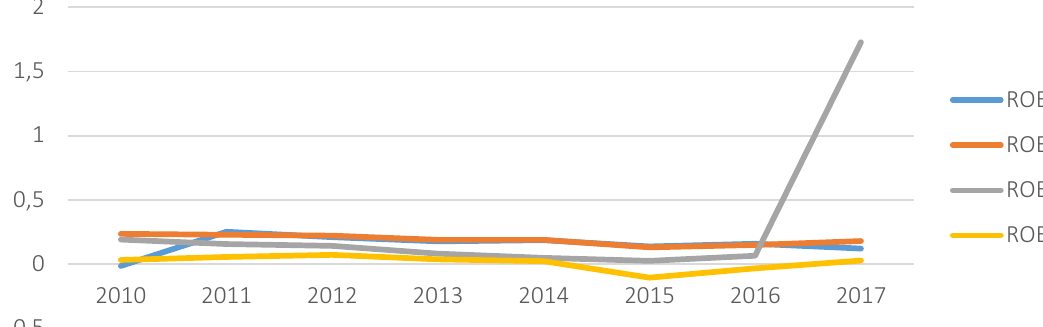
Figure 9. Comparison of mean of ROE between A1, A2, A3, and A4